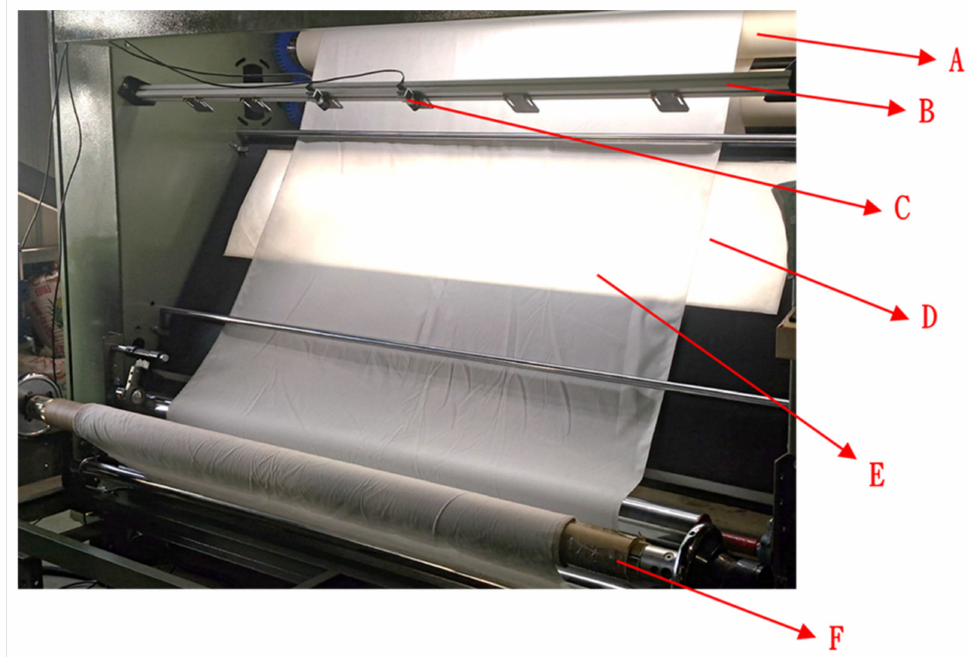
Figure 7. Actual structure of the experimental